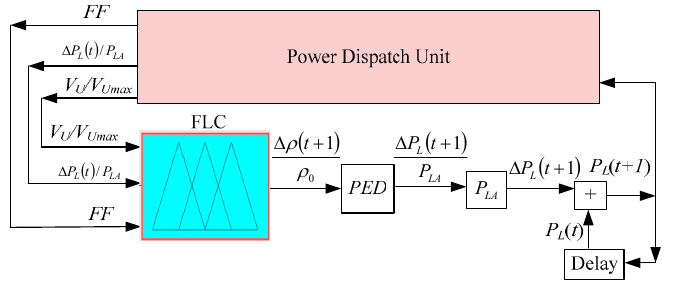
Figure 5. The block diagram of the demand response strategy with FLC.